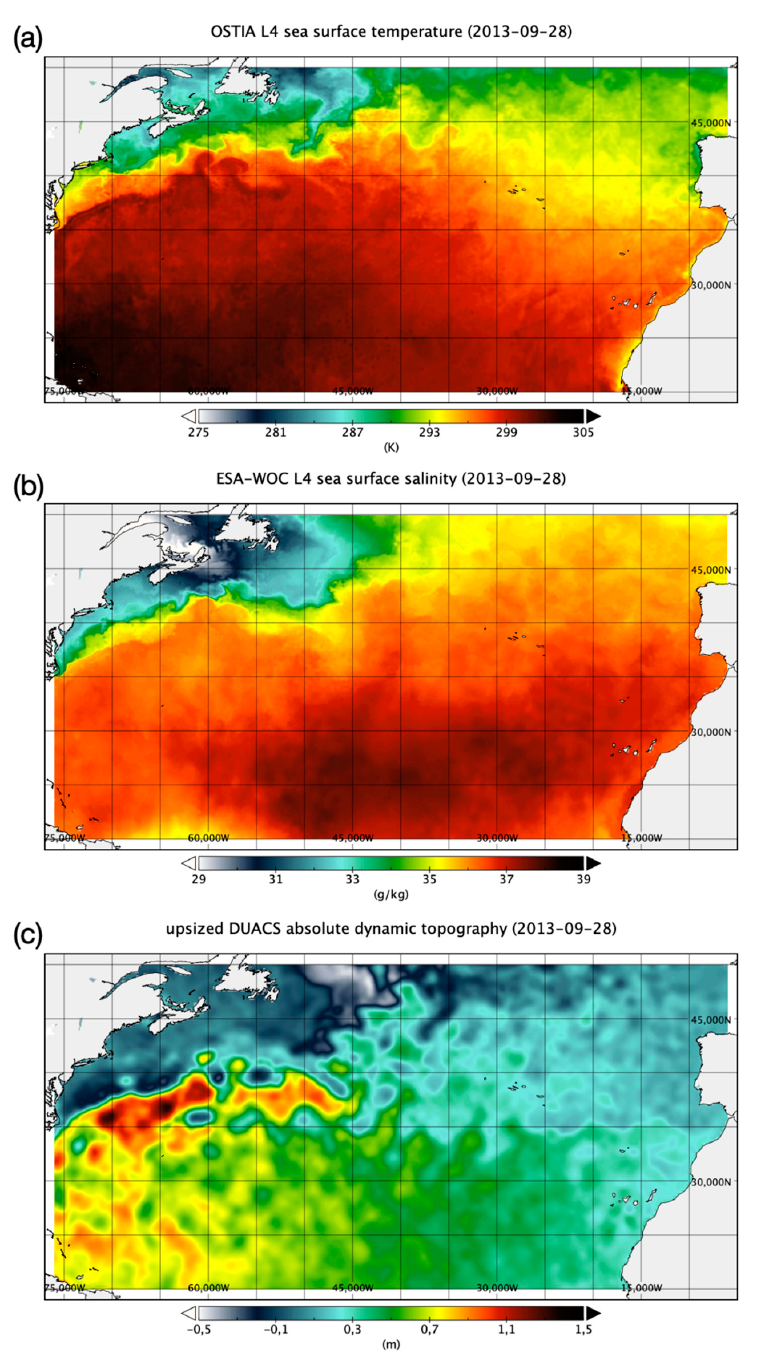
Figure 1. Examples of the surface daily data taken as input to the reconstruction techniques: OSTIA L4 reprocessed SST ( a ), SSS L4 developed within ESA-WOC project ( b ), adjusted ADT L4 derived from DUACS data ( c ).